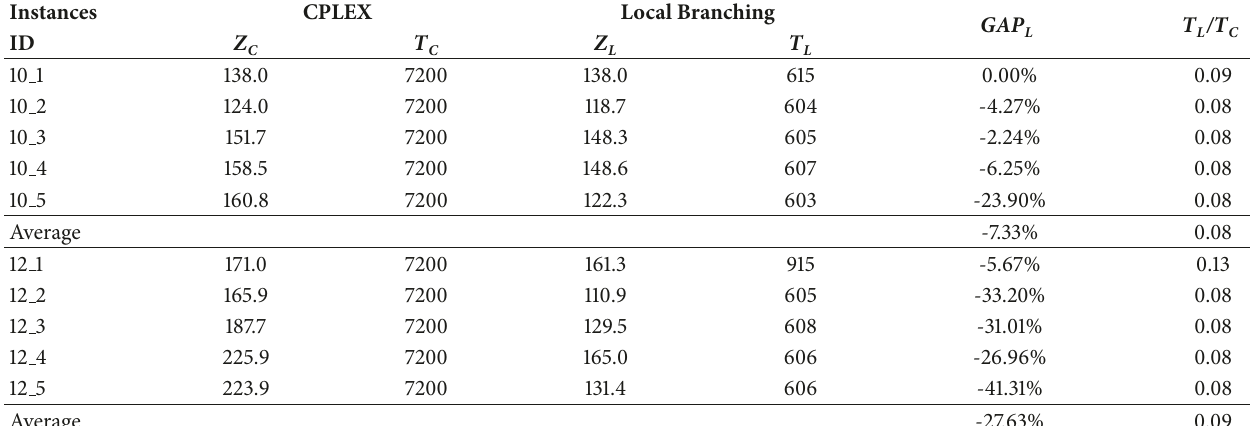
Table 1: The performance comparison of CPLEX and local branching based method.